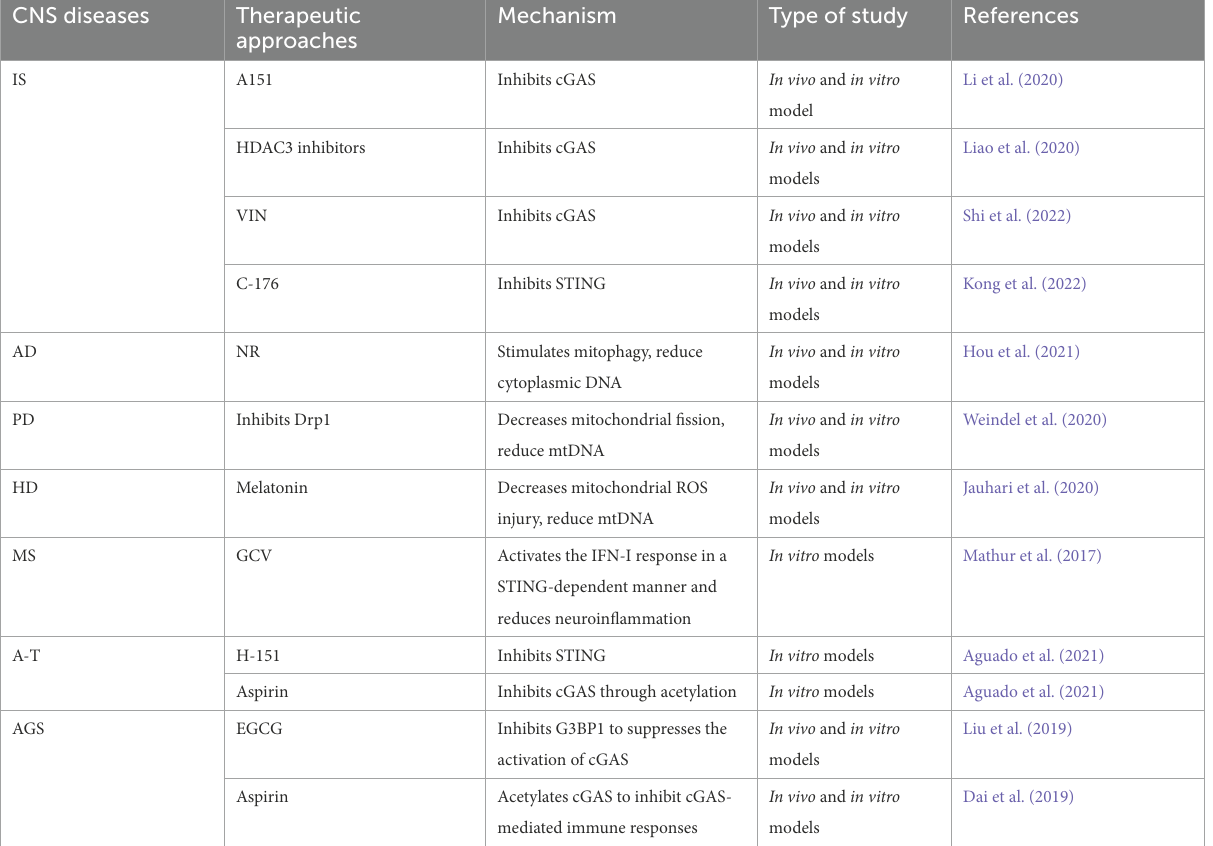
TABLE 2 Therapeutic approaches targeting cGAS-STING signaling pathway for central nervous system (CNS)